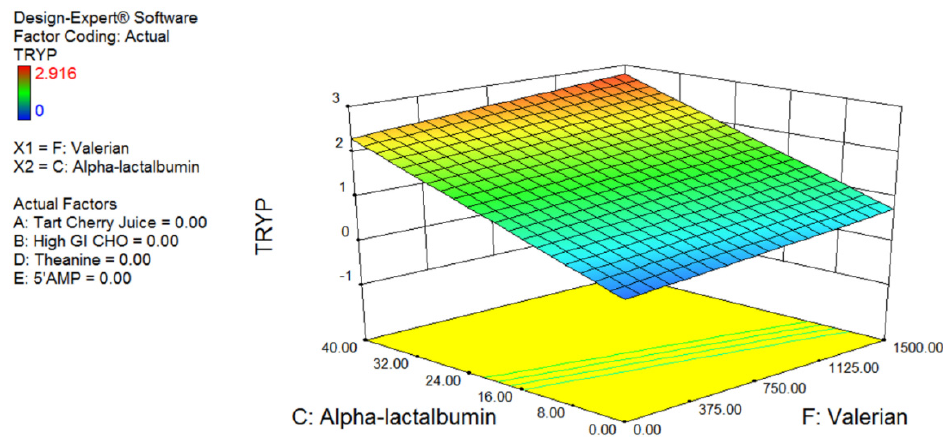
Figure 1. Quadratic response surface plot highlighting the effect of α‐ lactalbumin and valerian on blood tryptophan levels. The response surface represents all 55 measures. No other components affected this response surface.